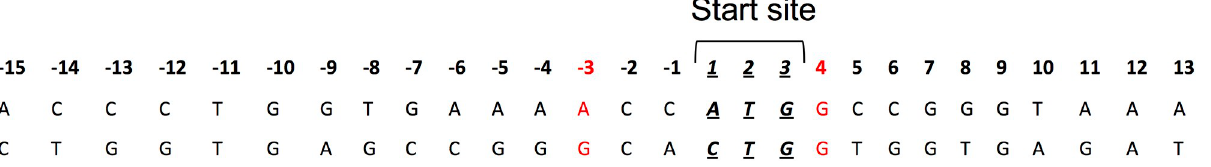
PLOS ONE | https://doi.org/10.1371/journal.pone.0214816 April 12,